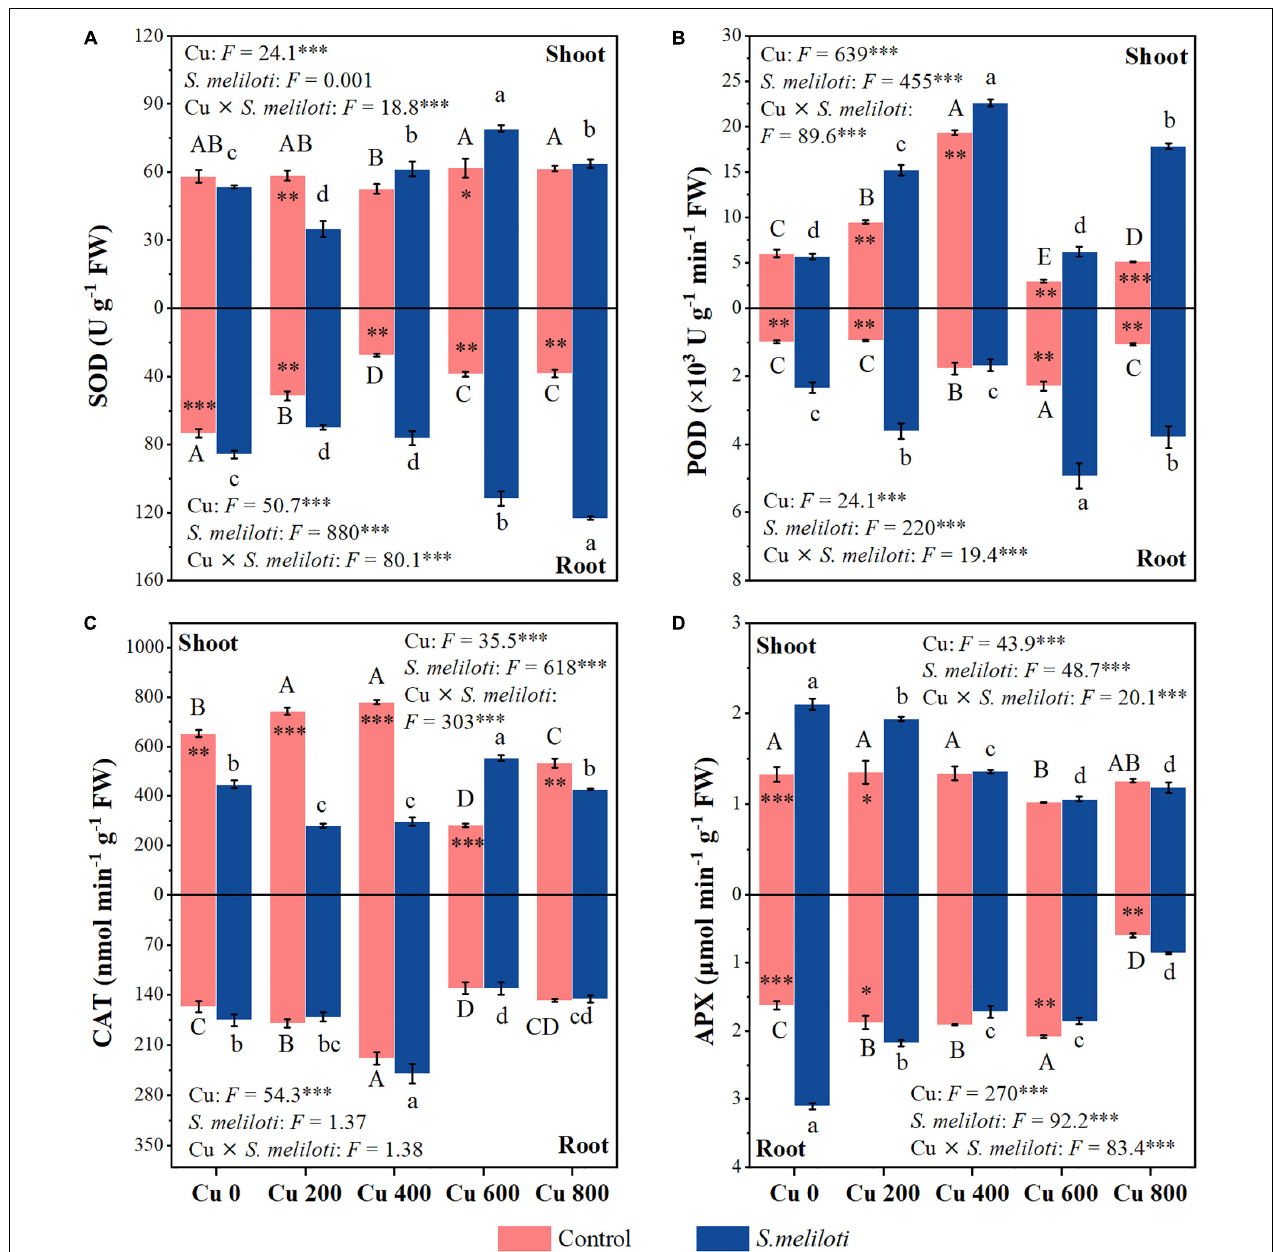
FIGURE 4 | The effect of inoculation with S. meliloti on plant antioxidant enzyme activities in alfalfa tissue. SOD, superoxide dismutase; POD, guaiacol peroxidase; CAT, catalase; APX, ascorbate peroxidase. The capitalized (Cu) and lowercase ( S. meliloti ) letters above the bars indicate significant difference between different Cu concentrations ( P < 0.05). The asterisks indicate significant differences between non-inoculated and inoculated alfalfa under the same Cu concentration condition. Each value represents the mean ± SE ( n = 3). *** P < 0.001; ** P < 0.01; * P <